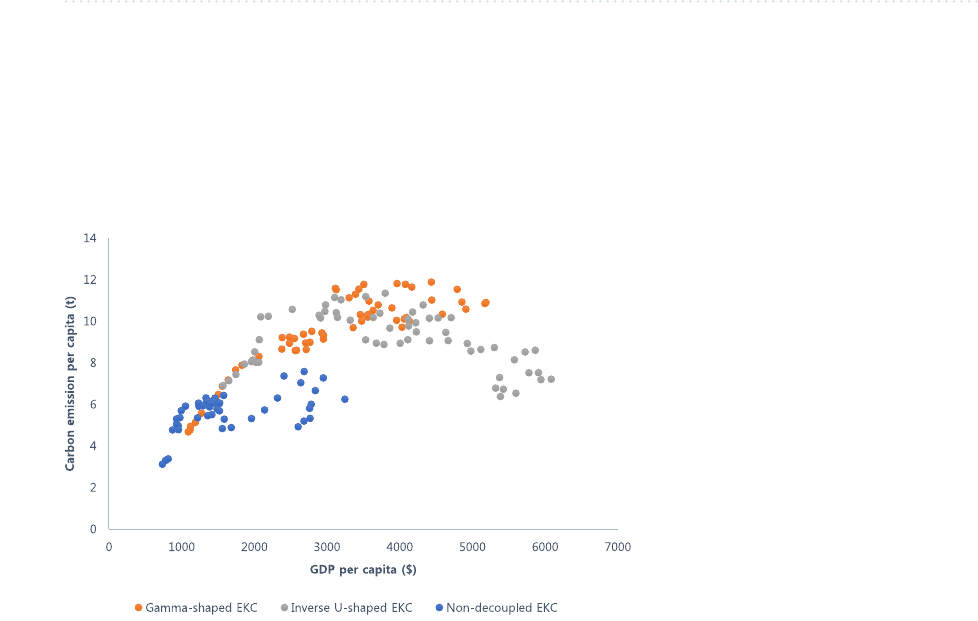
Table 1. List of (a) Decoupled countries and (b) List of non-decoupled countries.